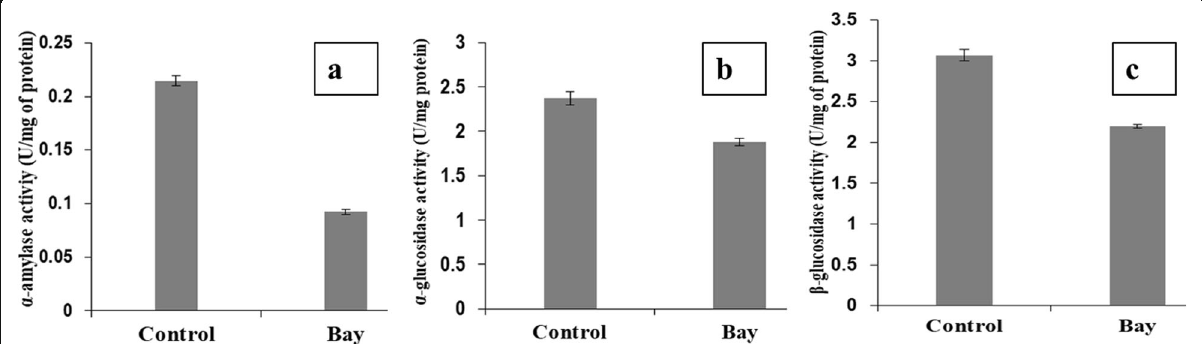
Fig. 3 Effect of bay essential oil on the gut enzymes of M . domestica larvae. a α -Amylase, b α -glucosidase, and c β -glucosidase activities of M. domestica. Values are means ± SE (standard error). Data analyzed by one-way ANOVA, followed by Tukey ’ s test and significance at * p < 0.001 compared with the control